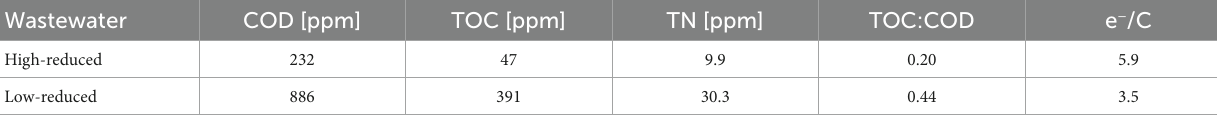
TABLE 1 Water quality parameters of the two type of brewery wastewater used in the screening.